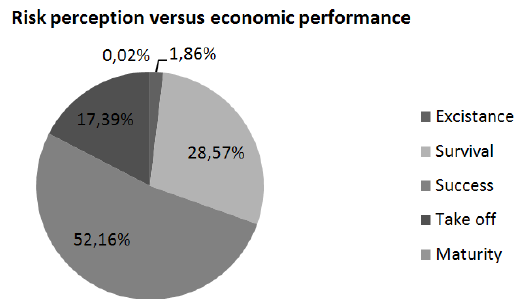
Fig. 10. Risk perception versus economic